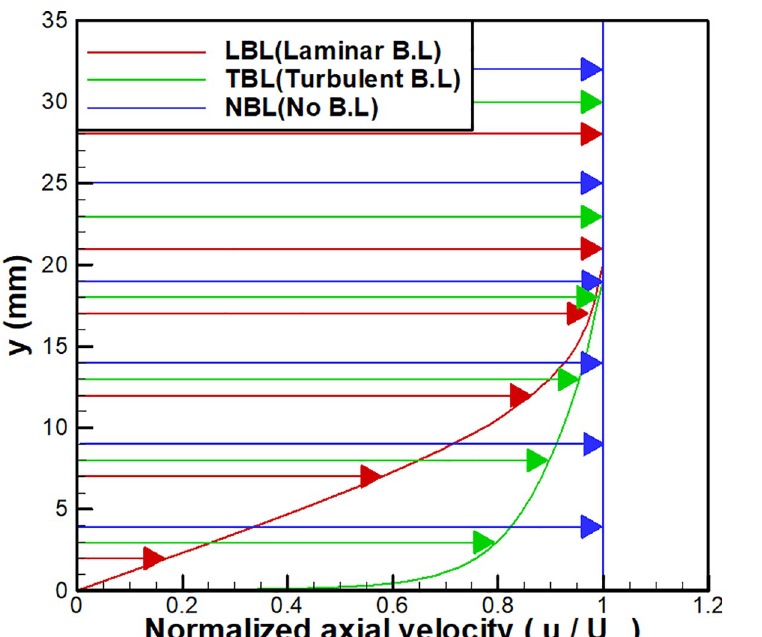
Fig 12. Velocity profiles for the laminar, turbulent and no boundary layer cases.